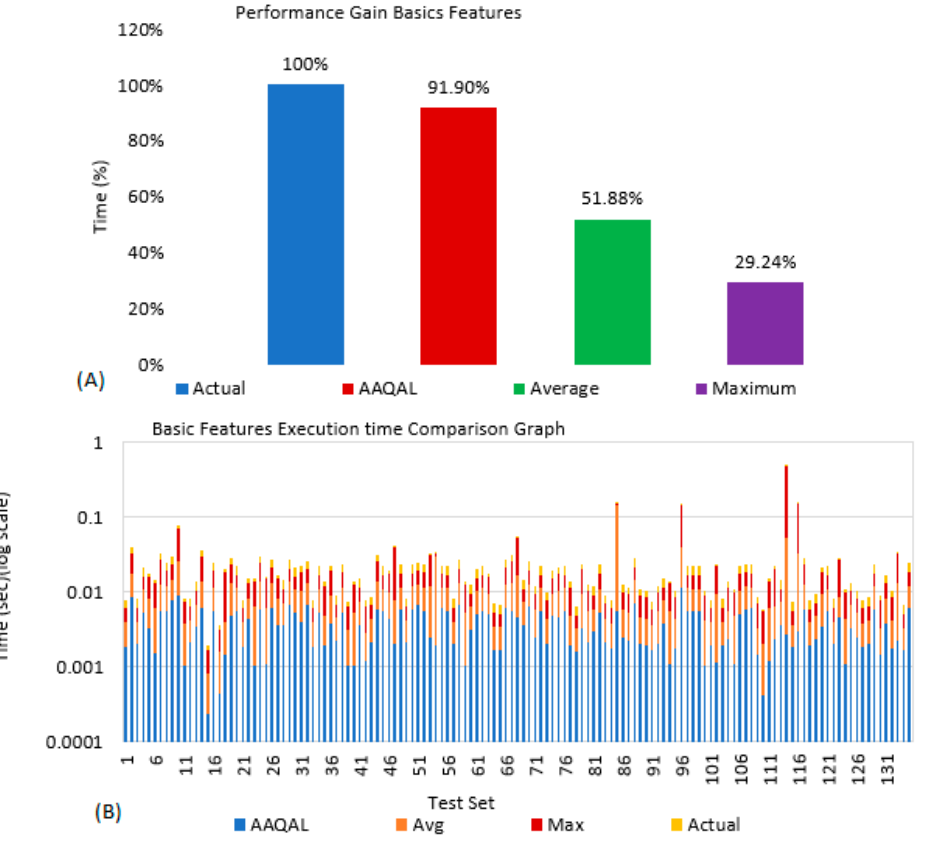
Figure 16. Performance gain with basic features ( A ) and execution time comparison ( B ) with basic features (test set).